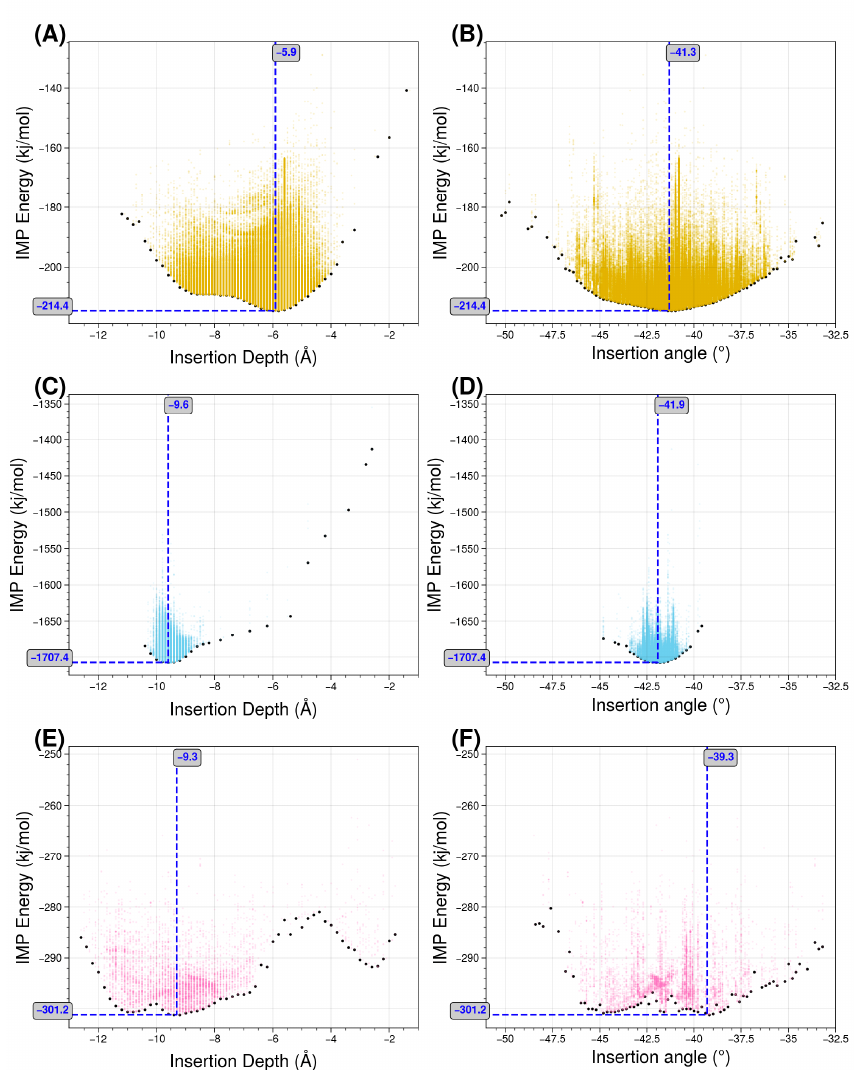
Figure 11. Monte Carlo insertion of maltoporin with three scales of representation: Levitt, Martini 3, and all-atom. The Monte Carlo parameters of temperature, translation, and angle are interactively adjusted to explore the space of angular and insertion depth values. The minimum energy depth and angle values are indicated by blue dotted lines and their values. ( A , B ) in orange the simulation using the coarsest model with the Levitt representation. ( C , D ) in blue, the results of the intermediate resolution Martini representation results with adjusted values for the transfer energy based on the octanol distribution and normalized to the theoretical surface area of the grains. ( E , F ) in pink, the most detailed Amber all-atom representation using the original values of [26] for comparison. The Martini 3 representation is closest to the original simulation reported by Brasseur’s team.